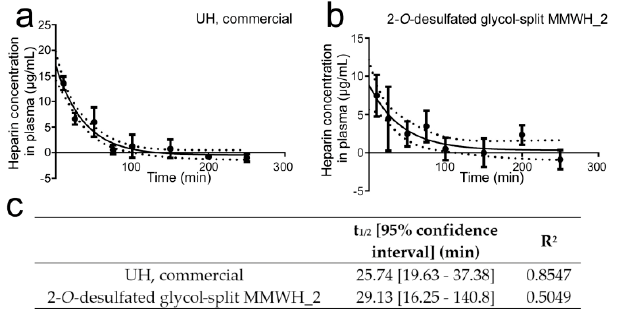
Figure 7. Determination of blood circulation time for unfractionated heparin (UH) and 2- O -desulfated glycol-split MMWH_2. ( a , b ) Concentration of both heparins in mouse plasma along time following intravenous administration to three male and three female mice for each time point. ( c ) Blood half-life values (t 1/2 ) for both samples and R 2 of the plotted curves.